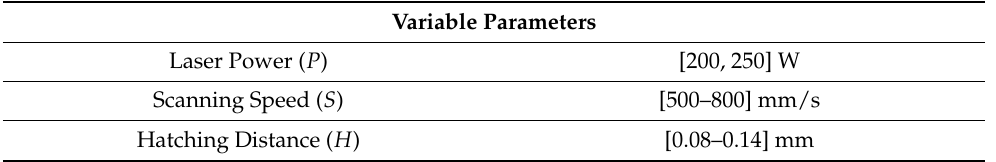
Table 2. Parameters used in the design of